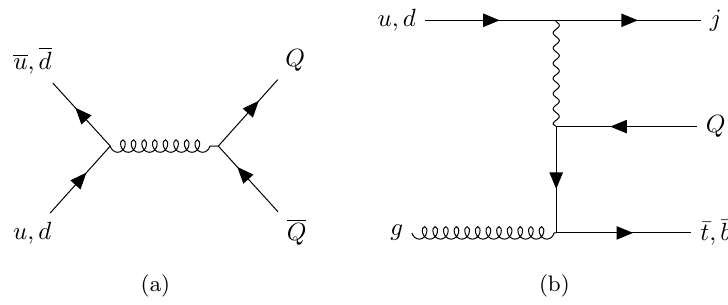
Figure 3 . Production of heavy quarks in hadron colliders: (a) example diagram for pair production; (b) single production in association with a light jet j and a heavy Standard Model quark q = t; b . Top